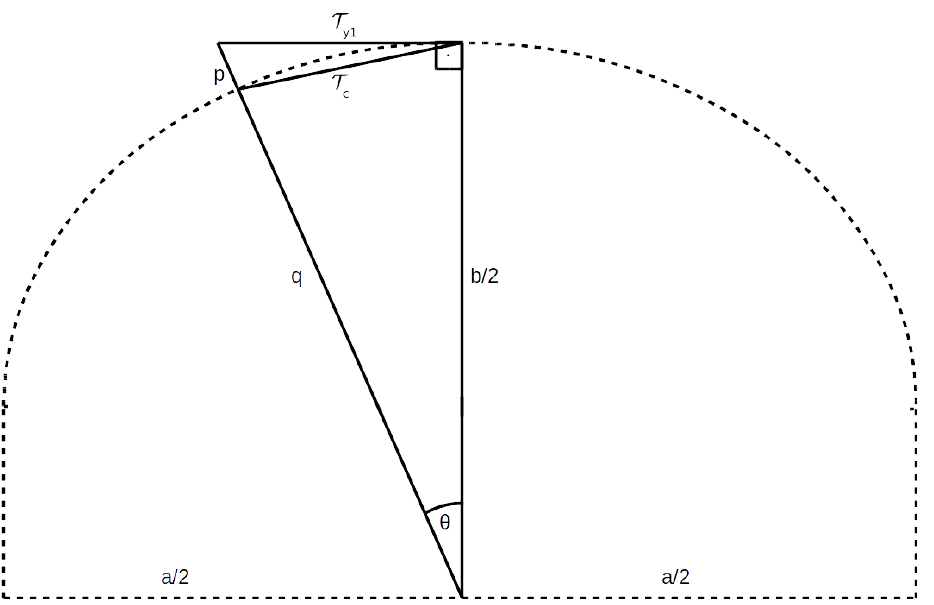
Figure A1. The upper part of a tunnel with an arbitrarily convex but symmetric ceiling. Note that T y 1 and b /2 always form a square angle, therefore p